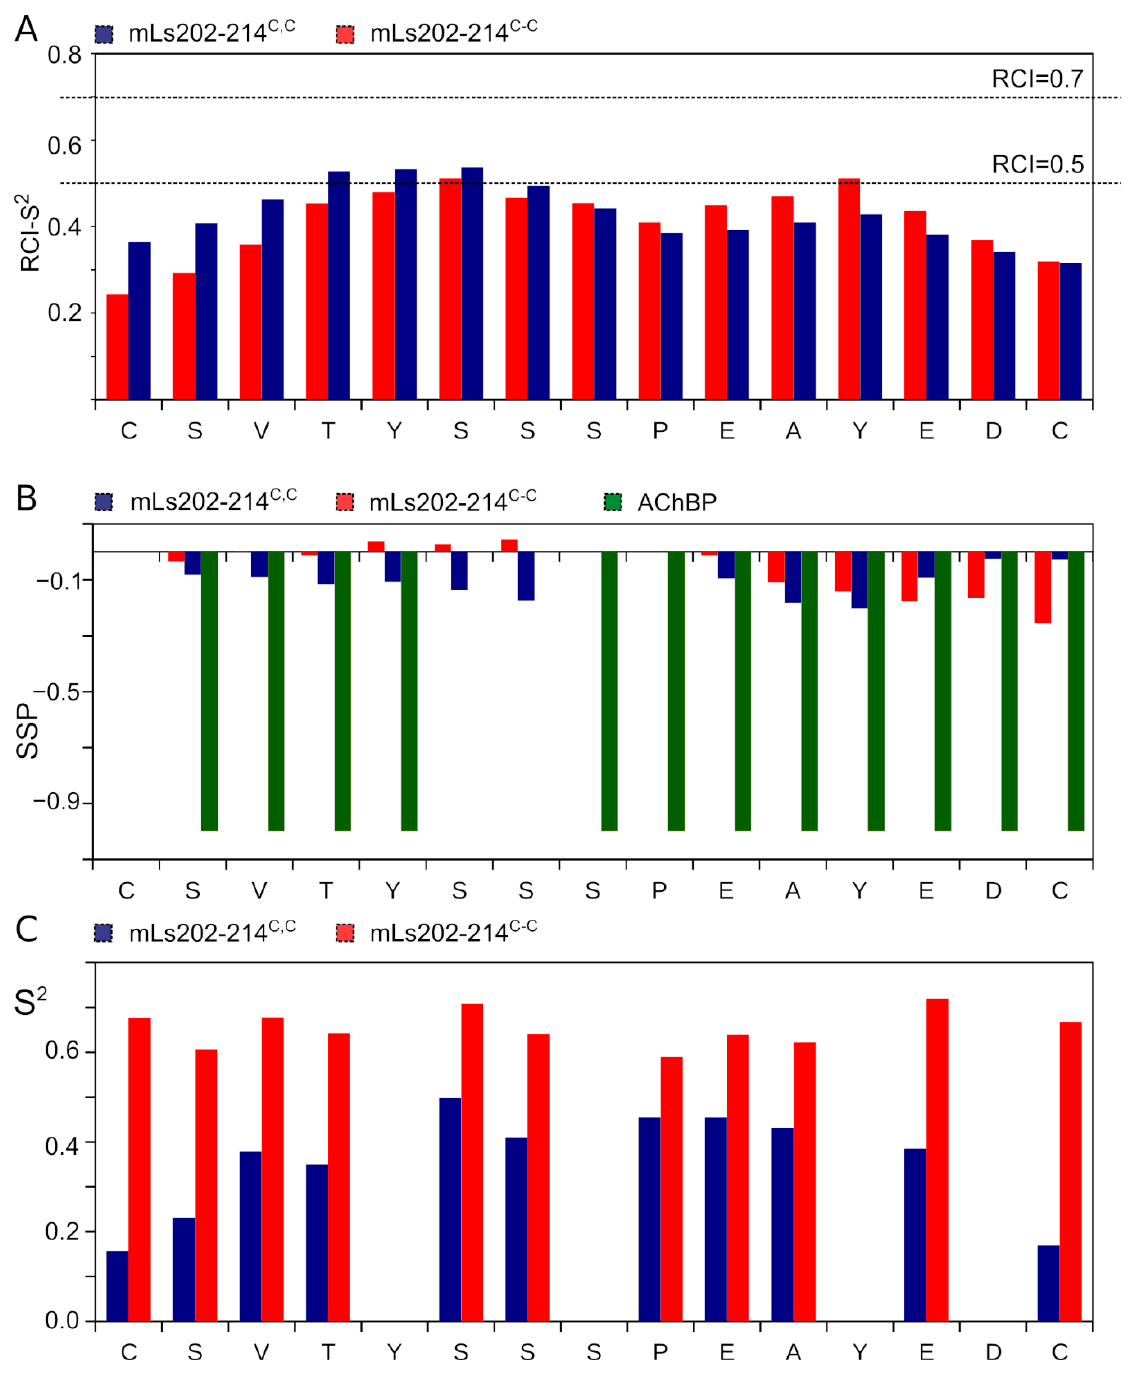
Figure 5. Distributions of RCI-S 2 ( A ), SSPs ( B ) and order parameters of C α H bonds ( C ) for m Ls 202–214 C,C (blue bars) and m Ls 202–214 C-C (red bars). Negative values of SSP correspond to the β -sheet or extended conformation. SSPs for the secondary structure of the 202–214 region of full-length L. stagnalis AChBP (PDB ID: 1UX2) is shown by green bars on panel B for comparison.